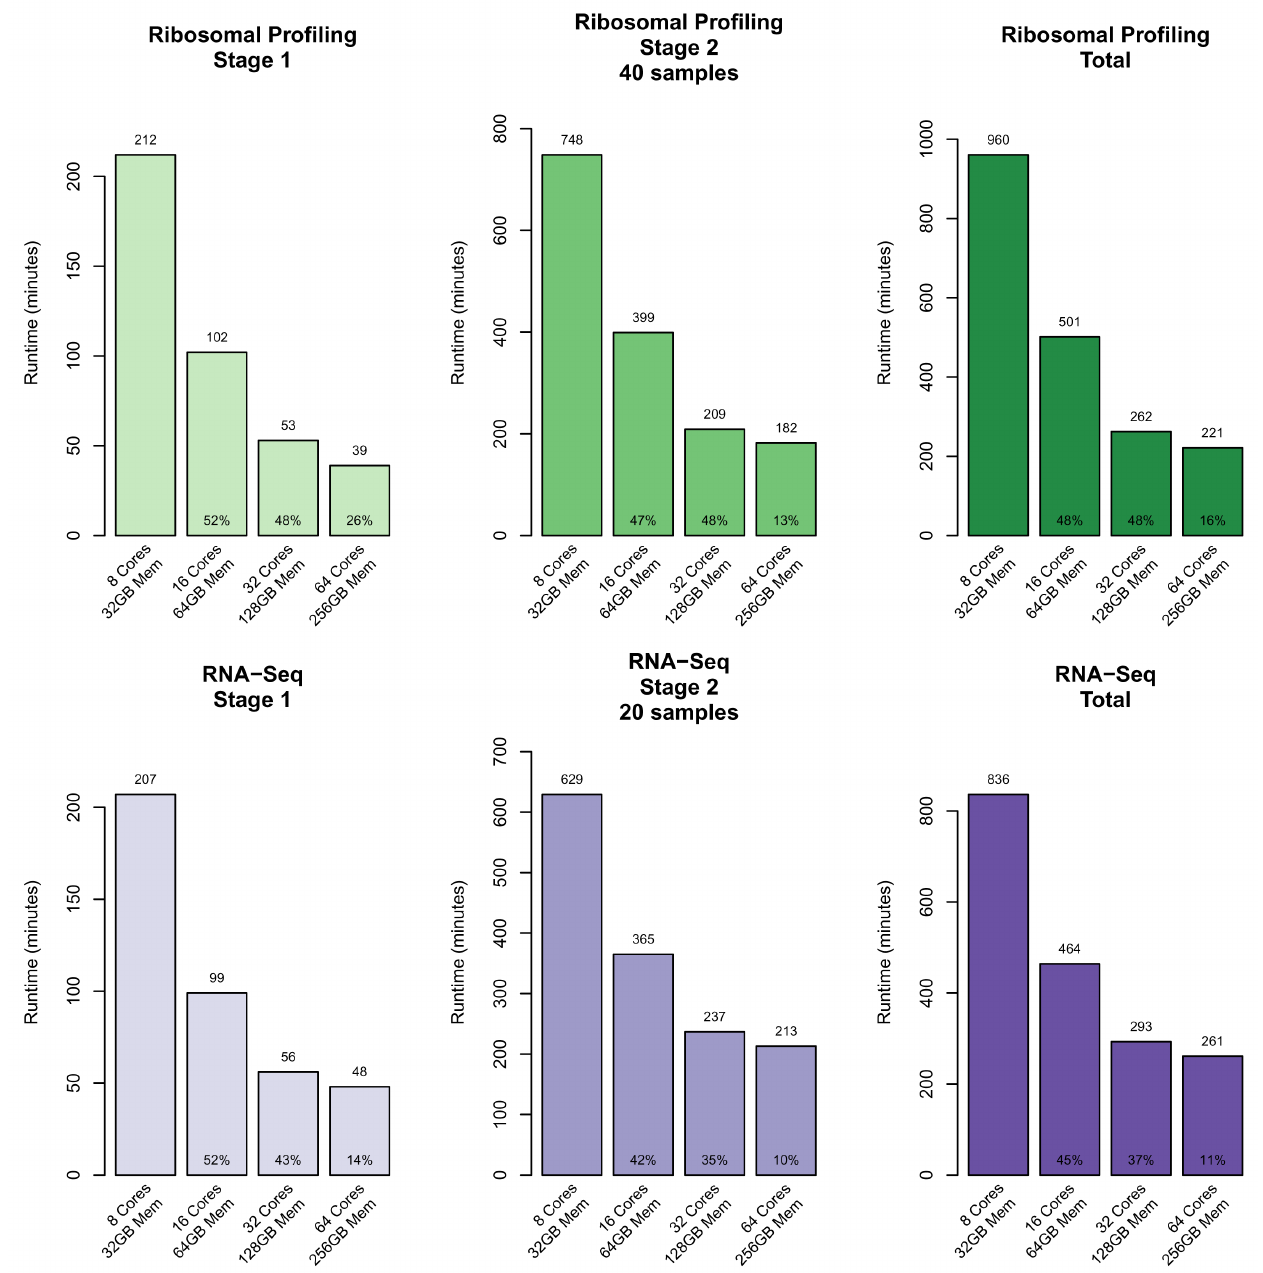
Figure 5. Dengue virus case study: Computational processing benchmarks for different AWS EC2 instances. The two ribosomal pre-processing stages were run using increasingly larger AWS instances to assess scalability and to estimate runtimes. The following AWS instance type were utilized: 8 Core 32GB Mem: m5.2xlarge AWS instance; 16 Core 64GB Mem: m5.4xlarge AWS instance; 32 Core 128GB Mem: m5.8xlarge AWS instance; 64 Core 258GB Mem: m5.16xlarge AWS instance.